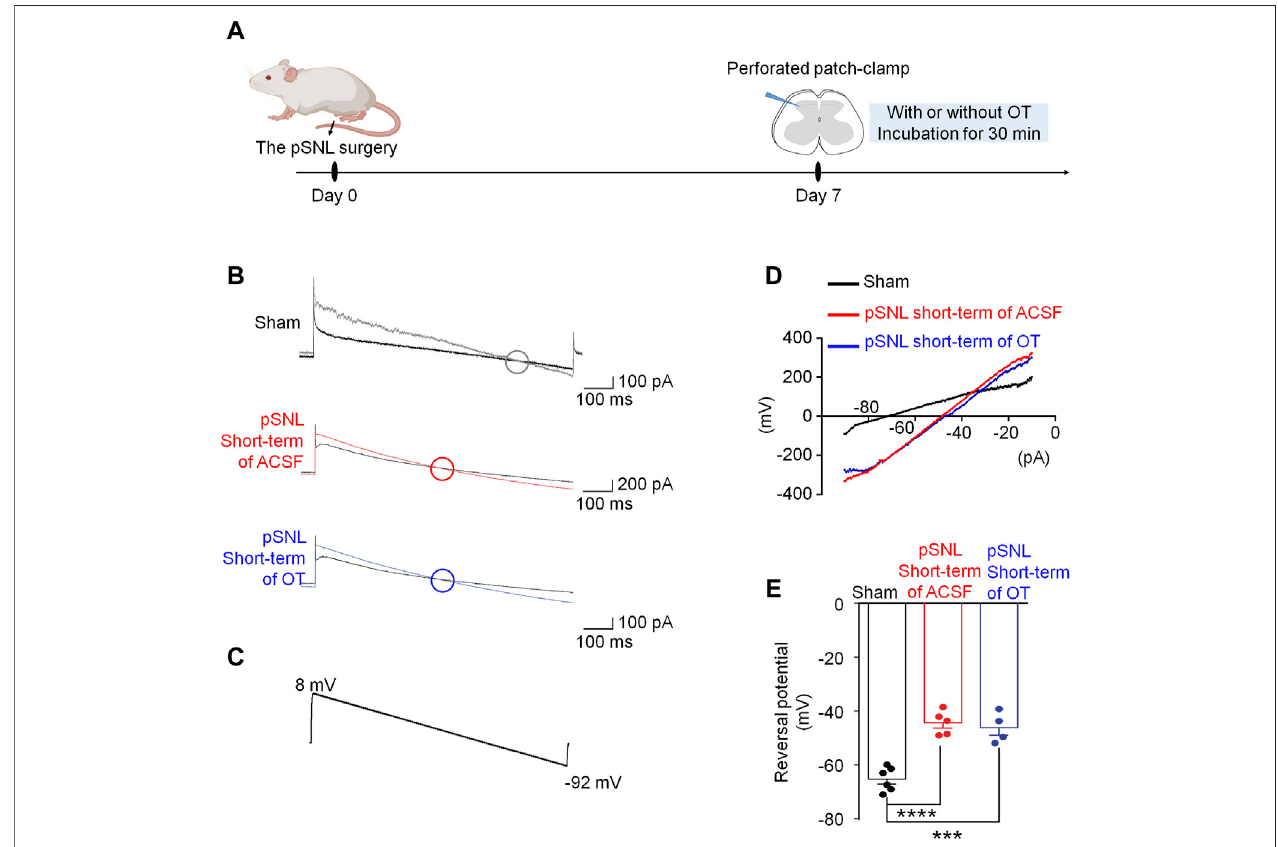
FIGURE4| Short-termOTincubationfailedtorenormalizeEGABAinspinaldorsalhorn. (A) Theschematicsoftheelectrophysiologicalrecording. (B,C) Asvoltage rampswereappliedfrom+8to − 92 Mv (C) ,basalandGABA-evokedcurrents (B) wererecorded. (D,E) ThereversalpotentialofE GABA recordedfromslicesofnaïveand pSNLmiceincubatedwithOTorsaline.One-wayANOVAfollowedbyBonferroni ’ sposthoctest.Dataareexpressedasmean±SEM.*** p < 0.001,**** p < 0.0001naïve vs. pSNL incubated with saline or OT.